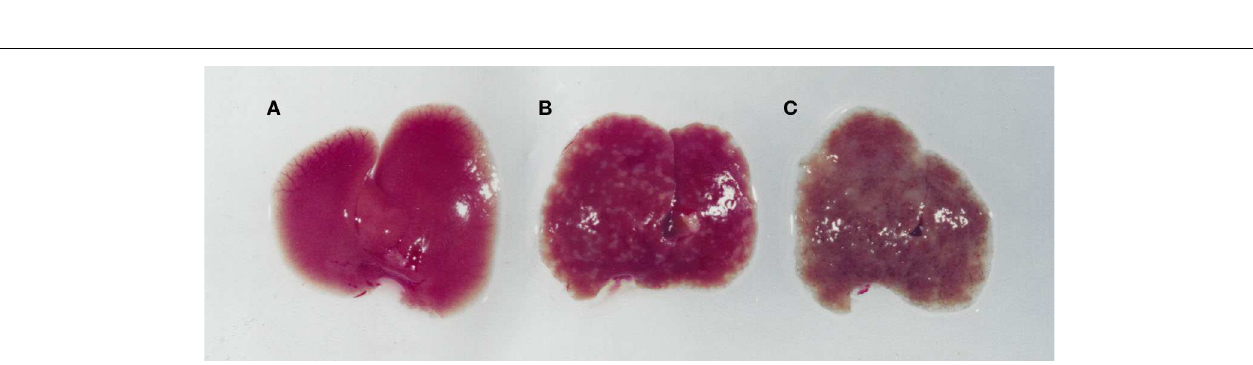
FIGURE 2 | Graphical representation of the cell populations involved in the formation of the S. mansoni egg-induced liver granuloma from an immune suppressed ( left ) and immunologically intact mouse ( right ).